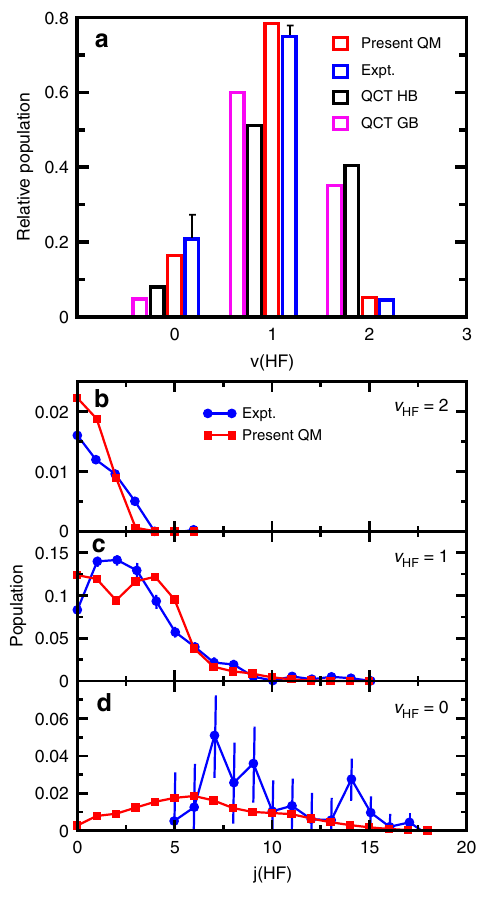
Fig. 2 Product-state distributions. The normalized HF vibrational state distributions ( a ) and rotational state distributions for each v ( b – d ) at the collision energy of 0.234 eV (5.4 kcal/mol), in comparison with the experimental values with error bars (SD) 16 and the quasi-classical trajectory results on the permutation invariant polynomial potential energy suface 22 . and Fig. 2b – d show the normalized rotational populations for each v ′ ( v ′ = 1 – 3), of product HF at the collision energy of 0.234 eV (5.4 kcal/mol). The present QM vibrational state distributions agree quite well with the experiment, while the previous QCT results overestimate the population for v ′ = 2. The calculated rotational state distributions, which changes from a broad one with a maximum at j = 6 for v ′ = 0 to a narrow one with a maximum at j = 0 for v ′ = 2, are also consistent with the experiment.